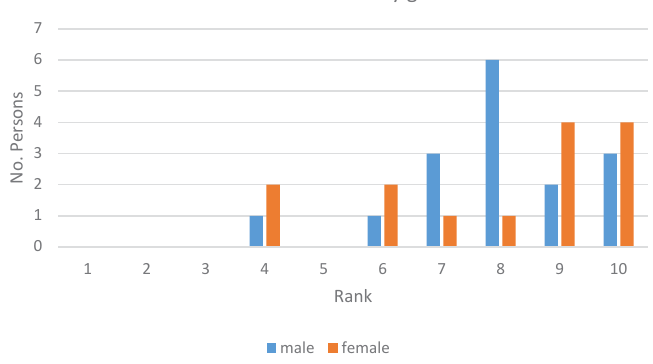
Fig. 2: Ranking community cleanliness by gender